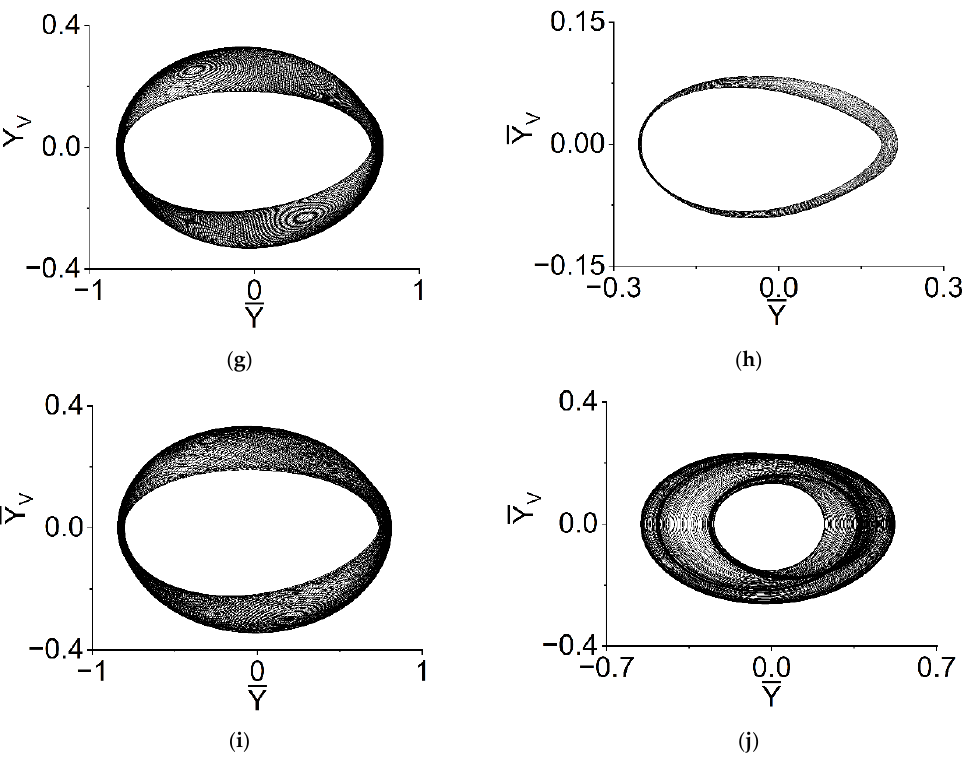
Figure 15. Phase maps of rotor system. ( a ) Rotor with Ω = 300 rad/s, ( b ) Bearing with Ω = 300 rad/s, ( c ) Rotor with Ω = 880 rad/s, ( d ) Bearing with Ω = 880 rad/s, ( e ) Rotor with Ω = 1250 rad/s, ( f ) Bearing with Ω = 1250 rad/s, ( g ) Rotor with Ω = 1330 rad/s, ( h ) Bearing with Ω = 1330 rad/s, ( i ) Rotor with Ω = 1400 rad/s, ( j ) Bearing with Ω = 1400 rad/s.